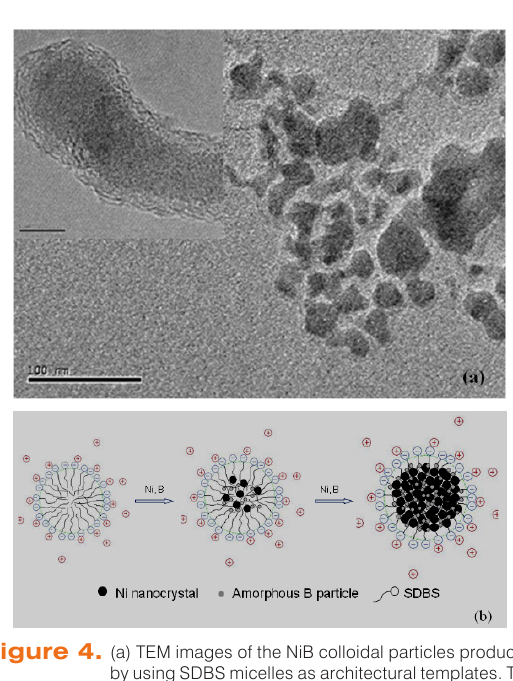
Figure 4. (a) TEM images of the NiB colloidal particles produced by using SDBS micelles as architectural templates. The scale bar represents 100 nm. The inset shows a high- resolution image of a cylinderical NiB nanoparticle (scale bar: 5 nm); (b) A schematic showing the possible formation steps of a NiB nanoparticle inside a SDBS